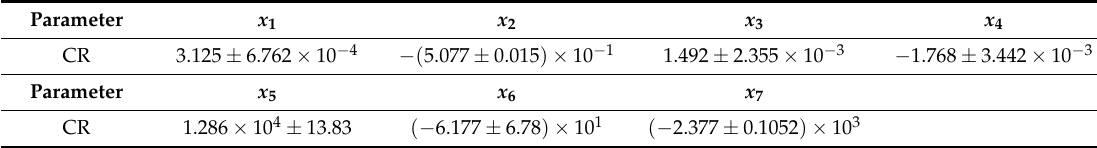
Table 4. The 95% joint confidence regions (CR) obtained from the simultaneous